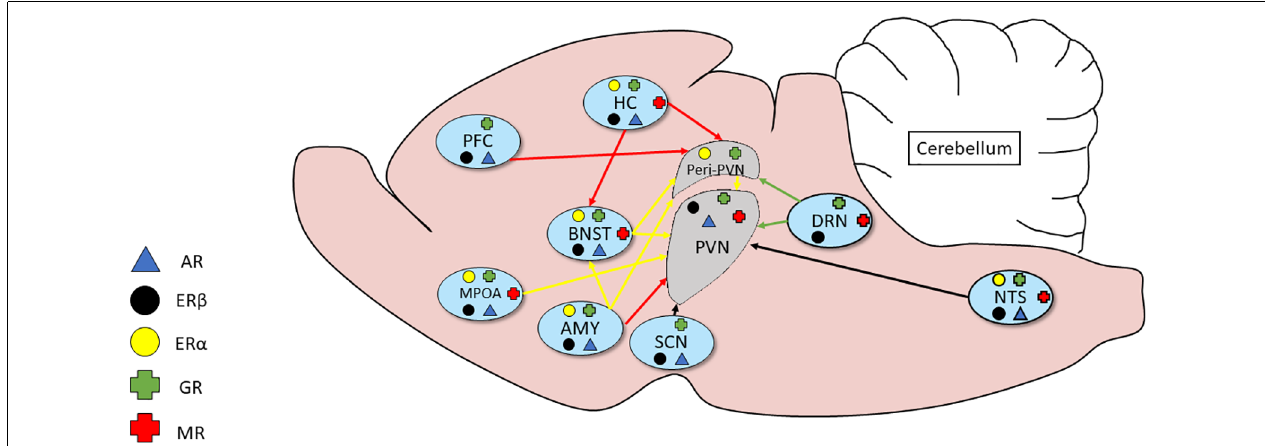
FIGURE 2 | Relationship of inputs of adrenal and gonadal steroid hormone receptors to the circuitry of the HPA axis. Several brain regions secrete adrenal and gonadal hormones that act on receptors in the peri-PVN and paraventricular nucleus (PVN). Much of the expression shows considerable